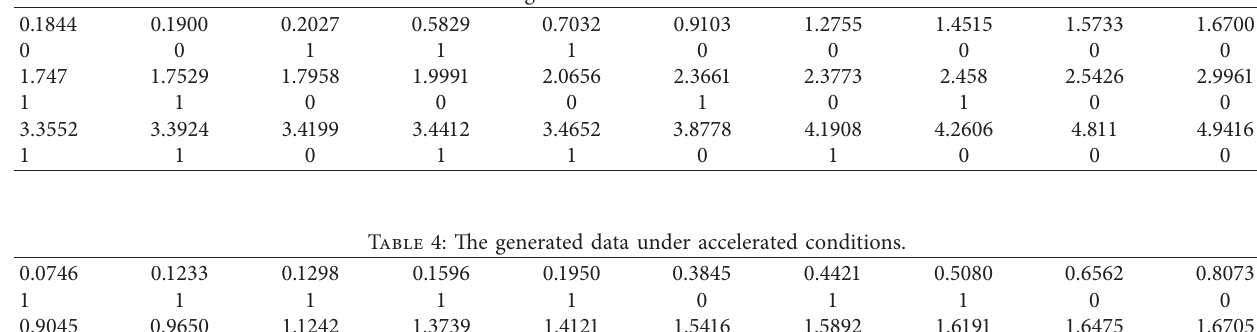
Table 2: MLs and PCs for 95% interval estimation ( α , θ